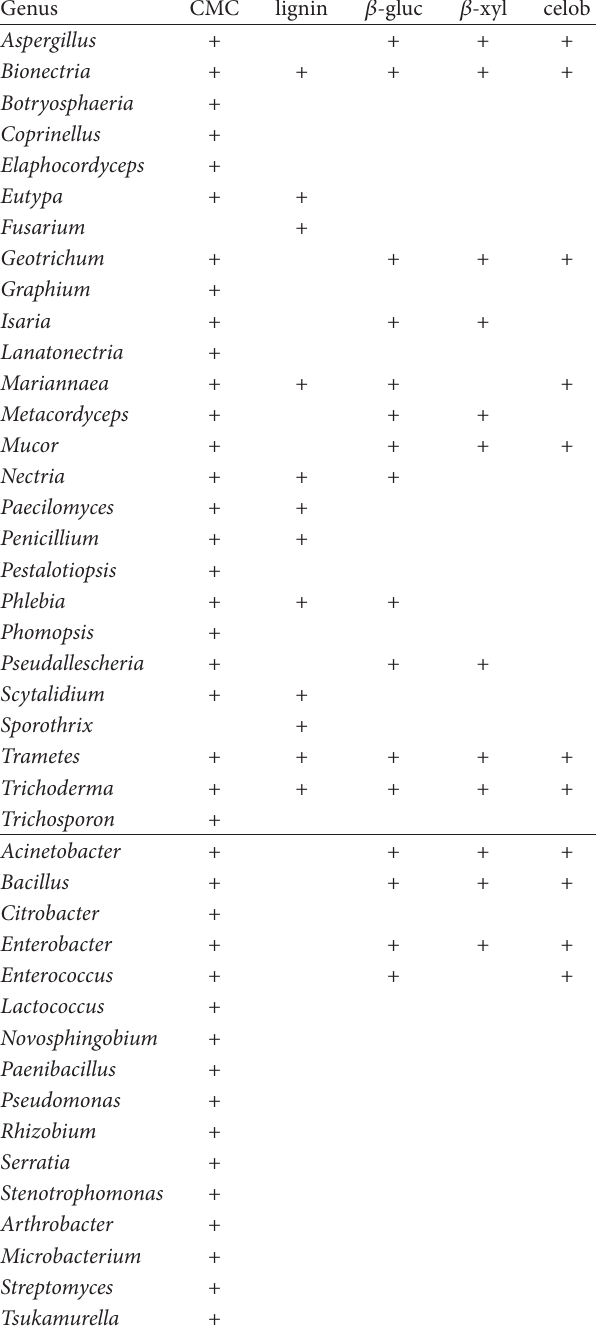
CMC:cellulaseactivityoncarboxymethylcellulose,lignin:ligninolytic activ- ityonRemazolBrilliantBlueR, 𝛽 -gluc: 𝛽 -glucosidase, 𝛽 -xyl: 𝛽 -xylanase,and celob: cellobiose hydrolase activity.